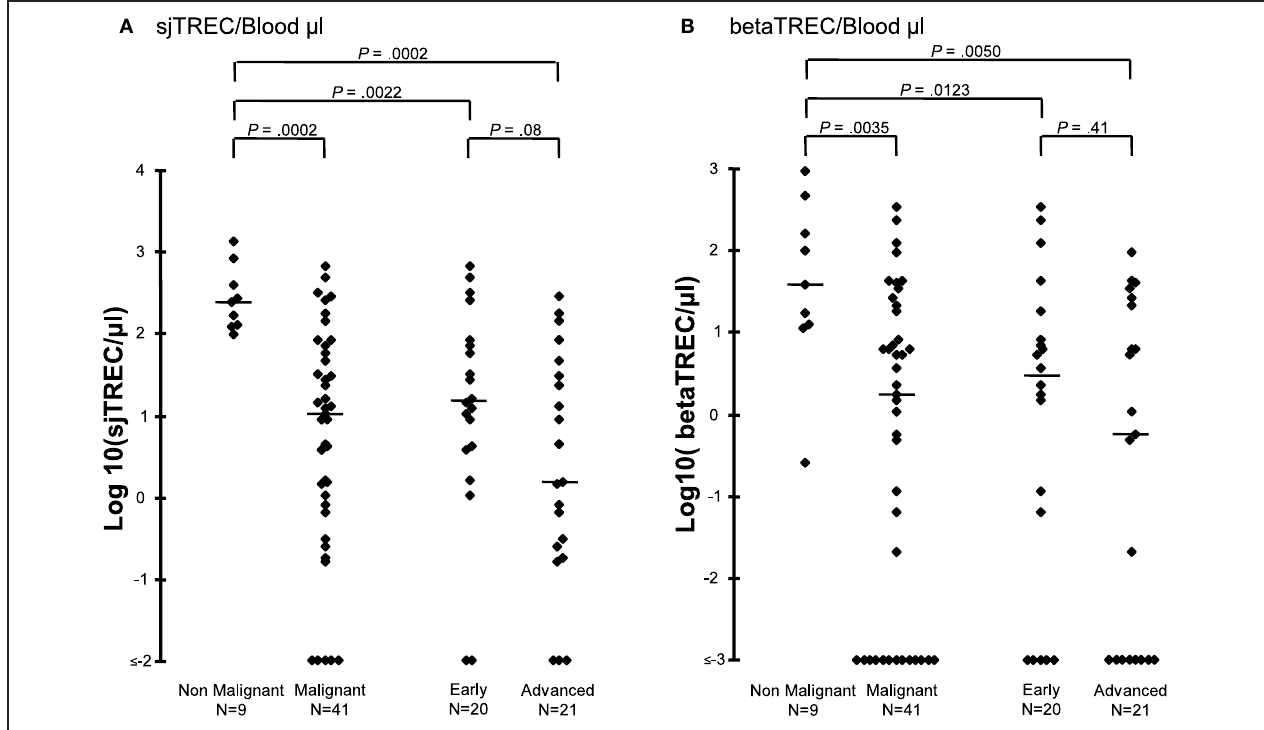
FIGURE 2 | Thymic function before transplantation is lower in patients affected by a hematological malignancy. Log10 sjTREC/blood μ L (A) and Log10 betaTREC/blood μ L (B) are shown before HSCT for patients diagnosed